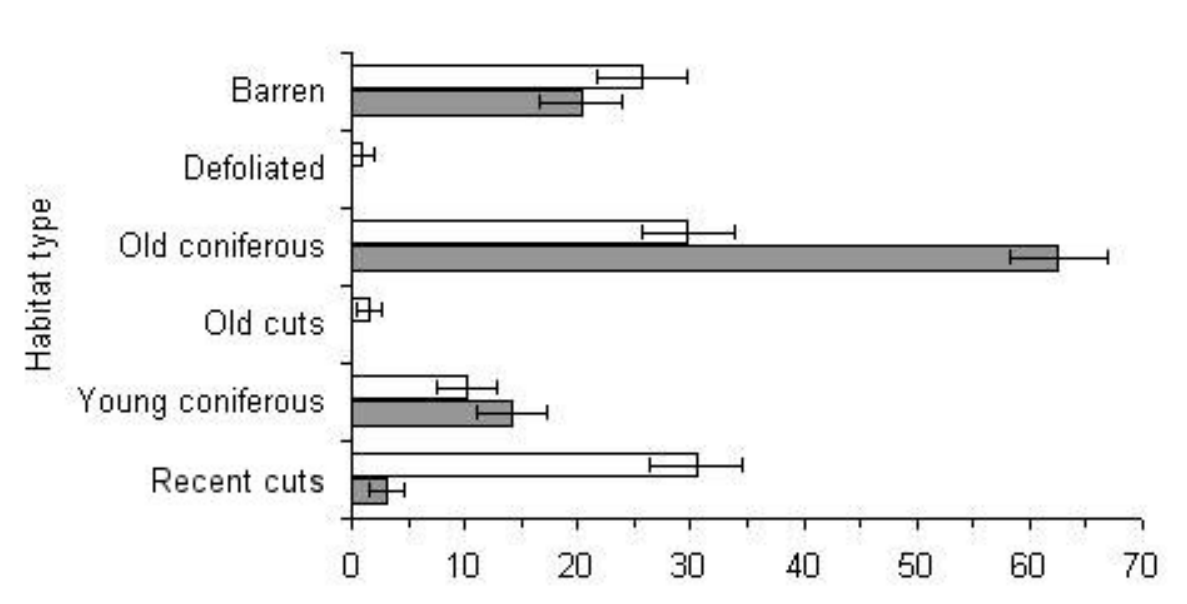
Fig. 4. Percentage (mean ± SE) of telemetry locations of foraging Black-backed Woodpeckers (gray bars: n = 128) and random points (empty bars: n = 128) falling in a given habitat